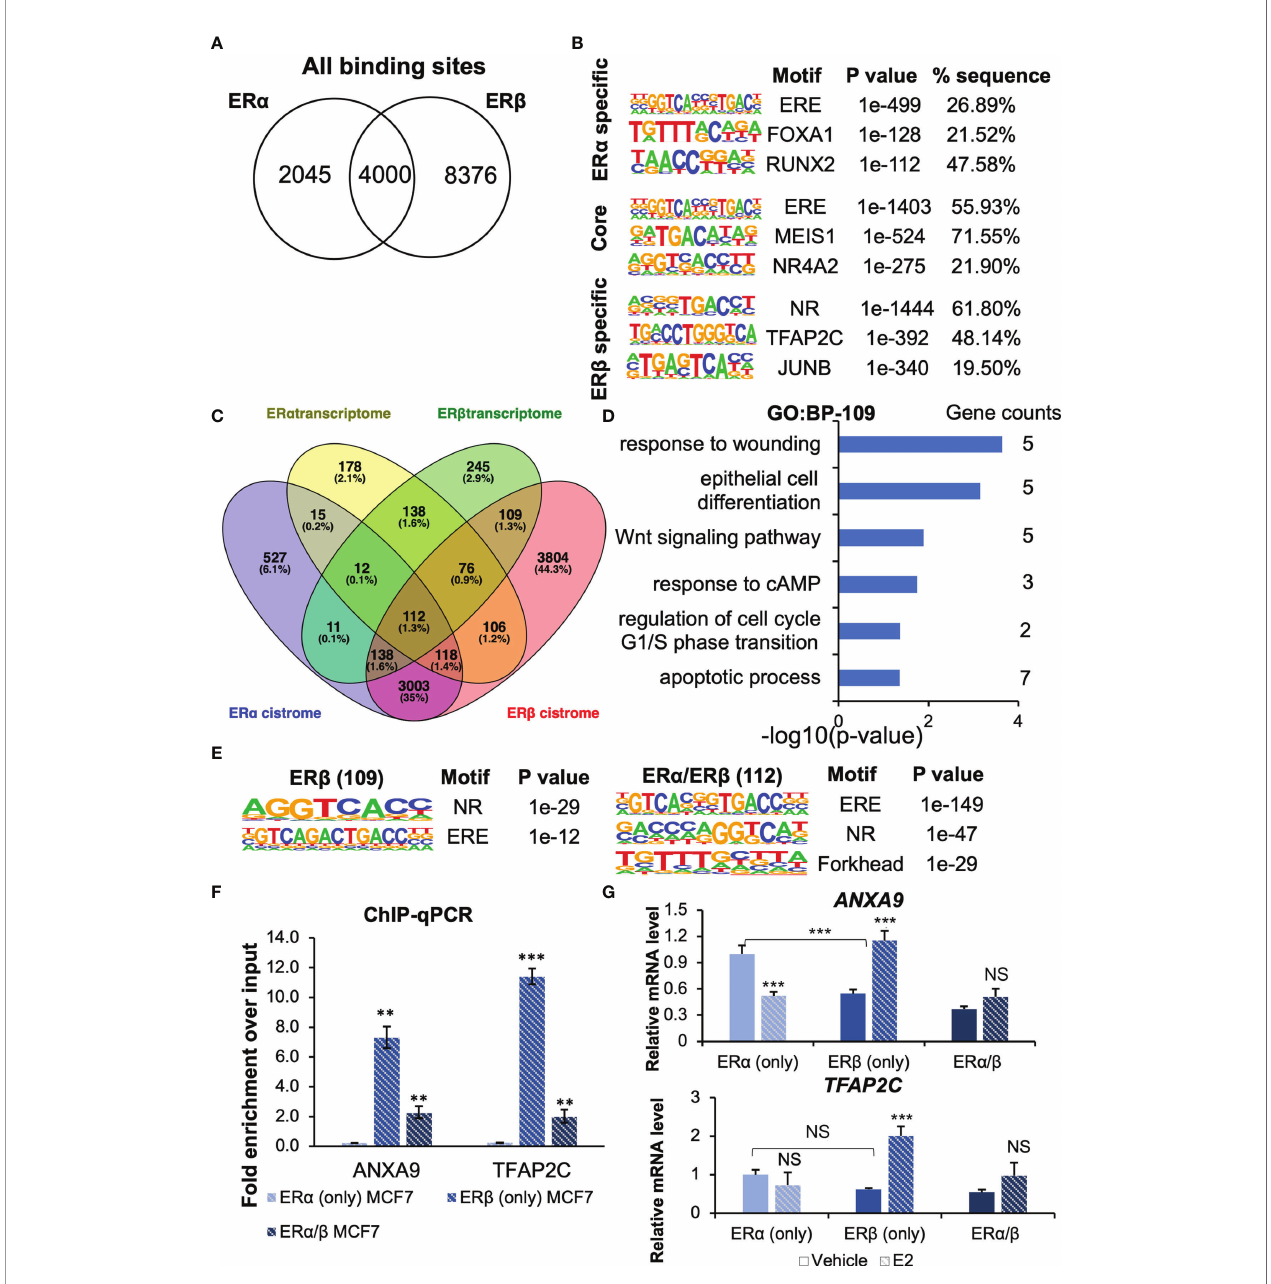
FIGURE 5 | The ERs cistrome and transcriptome. (A) Venn diagram comparing ER a and ER b binding sites. (B) Top-3 enriched motifs in ER a -speci fi c, common core, and ER b -speci fi c cistrome. (C) Venn diagrams of ER a and ER b transcriptome and cistrome data from MCF7 cells identify 109 genes regulated uniquely by ER b through both chromatin-binding and transcriptional regulation, but only 30 genes that are unique for ER a . (D) Enrichment analysis of biological functions for the 109 uniquely ER b -regulated genes. (E) Top-3 enriched motifs among ER b -speci fi cally regulated genes, and those regulated by both ERs. (F, G) Con fi rmation of ER binding and regulation of ANXA9 and TFAP2C with ChIP-qPCR and qPCR. Data is shown as means ± SD (n=3), and analyzed by two-way ANOVA followed by Bonferroni test. P < 0.05, ** P < 0.01, *** P < 0.001, NS, Not signi fi